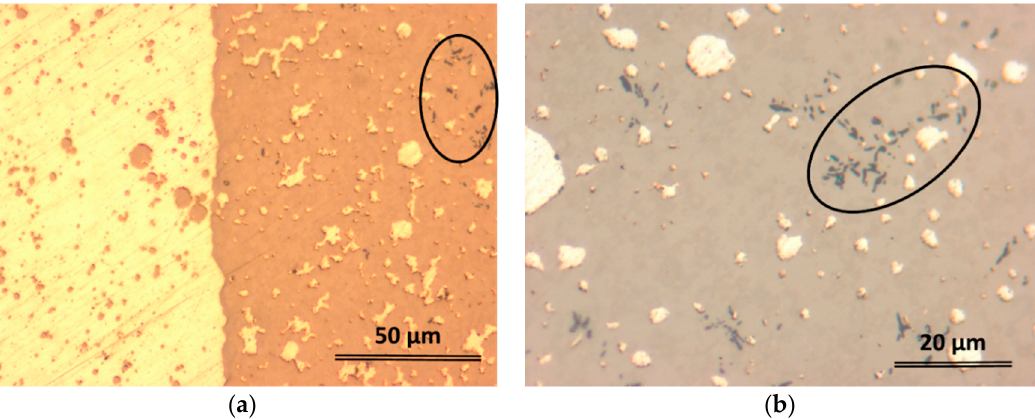
Figure 3. Optical micrographs showing the phase separation in ( a ) 5 mm diameter rod; and ( b ) 2 mm diameter rod.